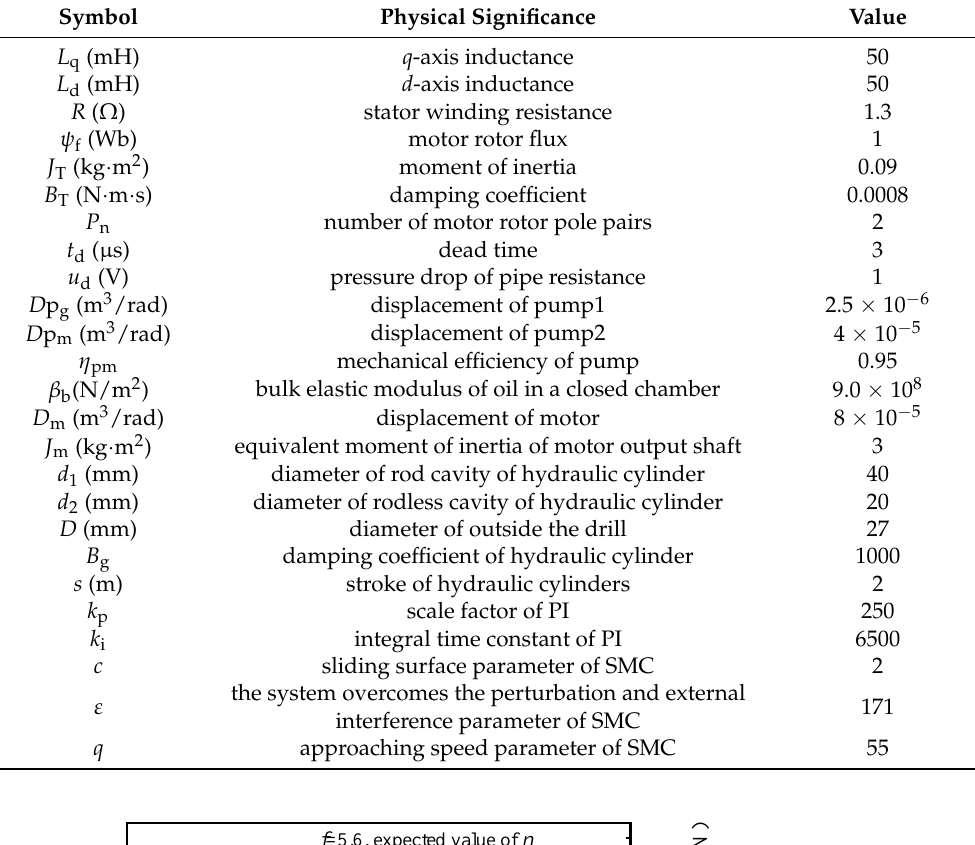
Table 1. Basic parameters of PMSM and the hydraulic system [27,30].